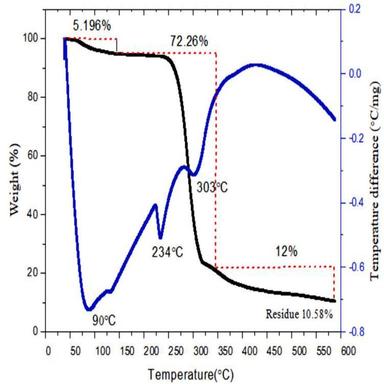
Thermal analysis – (TGA-DTA) - G4C3NBM.